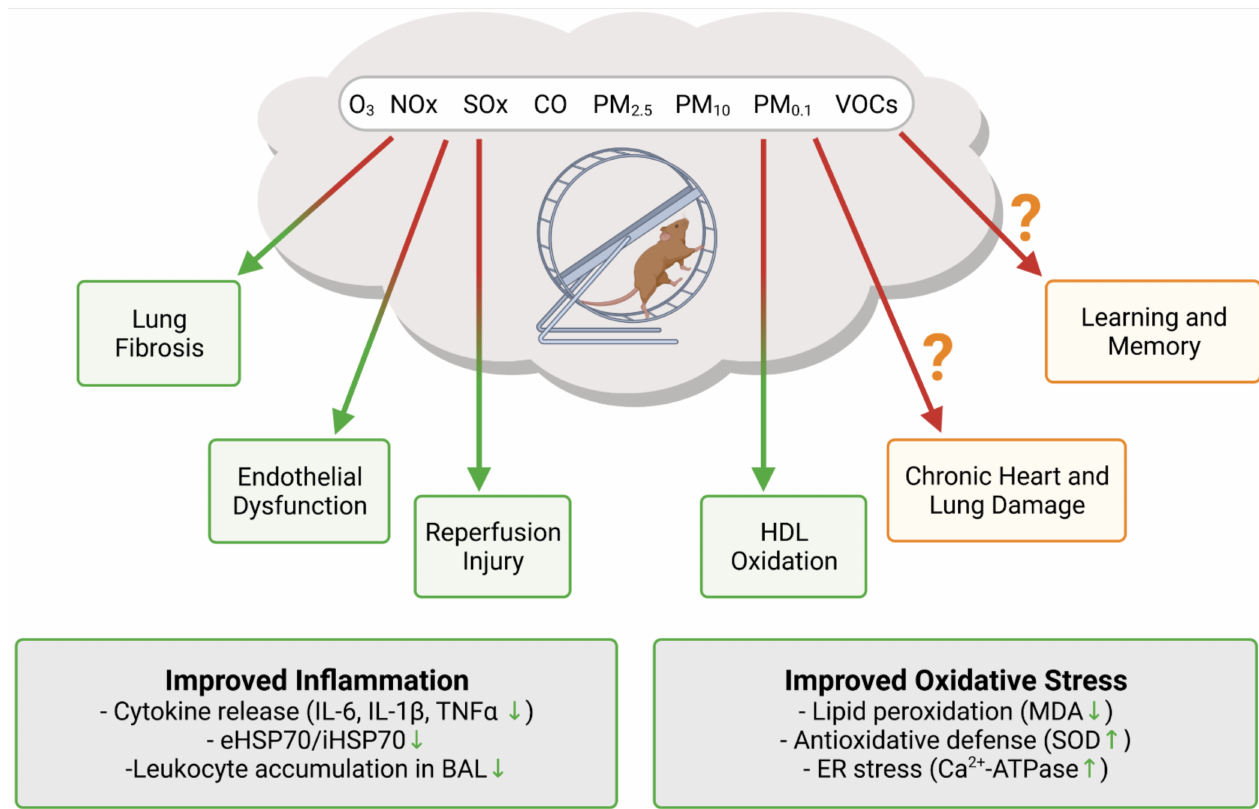
Figure 2. Insight into the synergistic effects of exercise and air pollution exposure from animal studies. Exercise was shown to offset air pollution mediated increase in oxidative stress and inflammation. It is still not clear if exercise in polluted air can ameliorate the detrimental effects of air pollution in the long term. Created with BioRender.com, accessed on 4 November